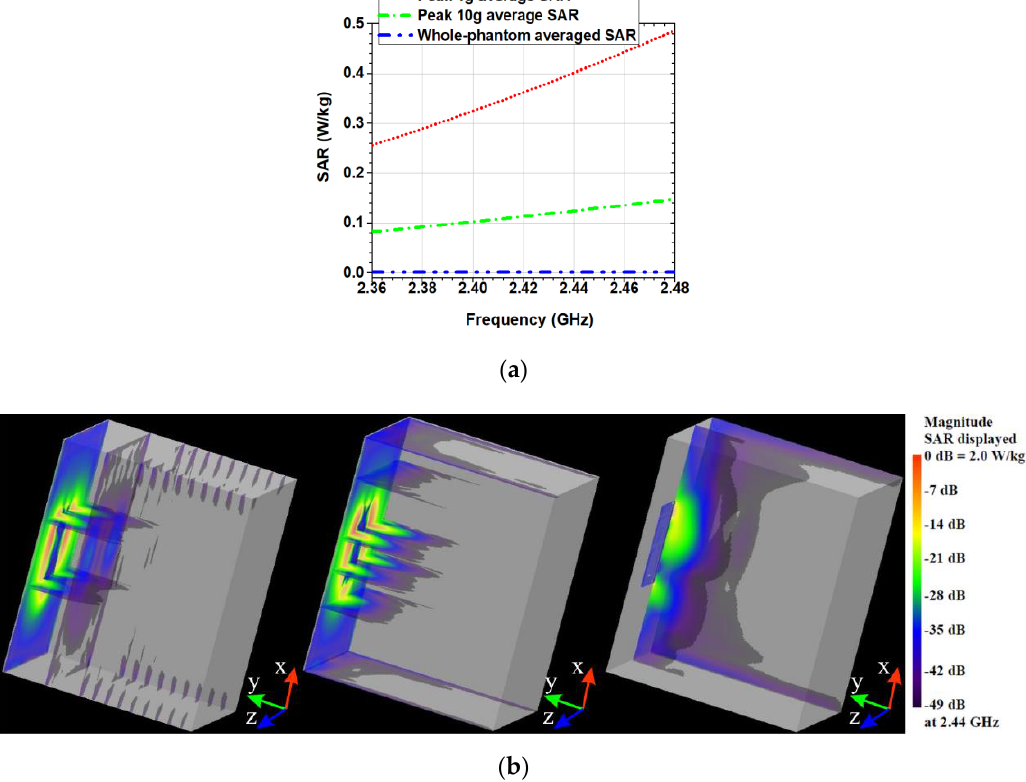
Figure 4. FDTD-computed SAR: ( a ) peak 1 g and 10 g average SAR, and whole-phantom averaged SAR versus frequency; ( b ) Distributions in xy-, yz- and zx-plane at 2.44 GHz and scale.